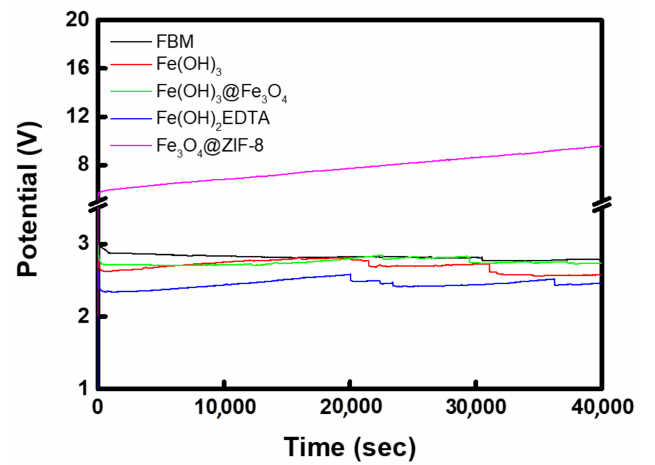
Figure 13. Chronopotentiometry curves exhibiting electrochemical stability of commercial and fabricated